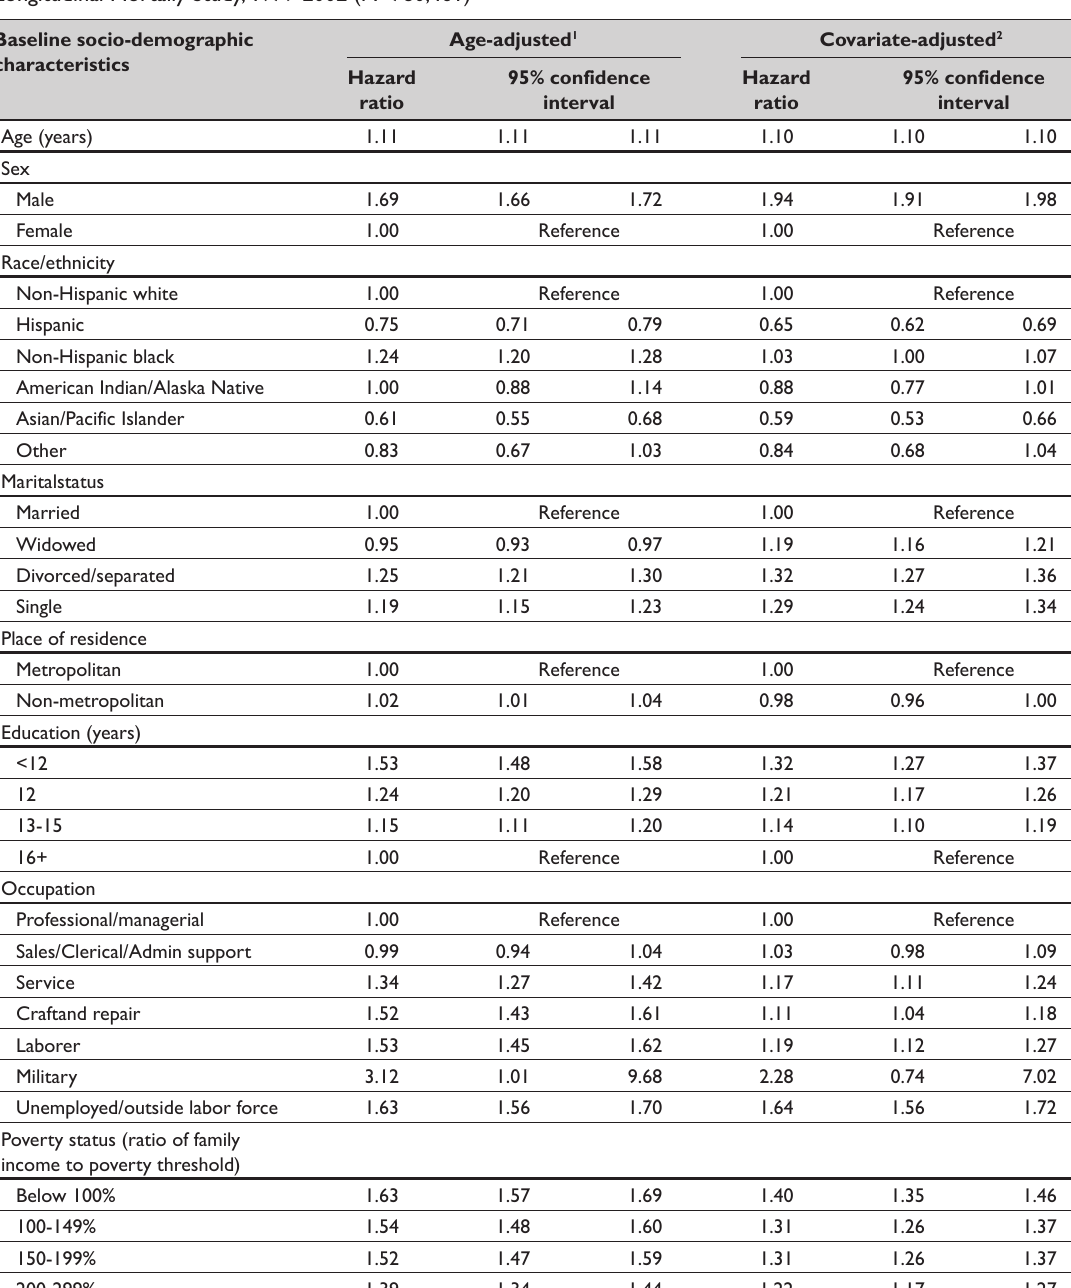
Table 1. Age- and Covariate-Adjusted Relative Risks of Cardiovascular Disease (CVD) Mortality Among US Adults Aged 25+years According to Baseline Socioedemographic Characteristics and Region of Residence: The US National Longitudinal Mortaliy Study, 1979-2002